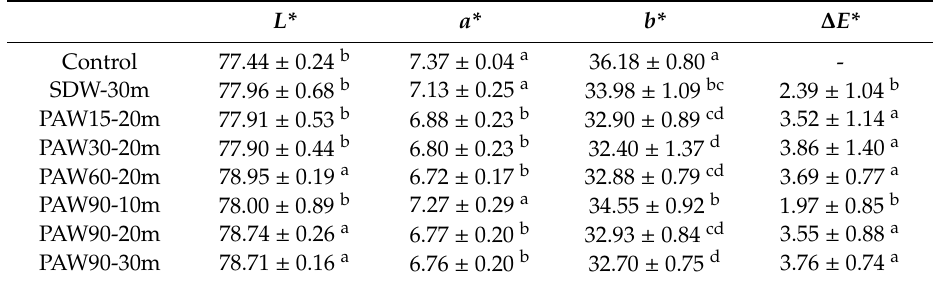
Table 1. Influence of plasma-activated water treatment on the color parameters of thin sheets of bean curd.